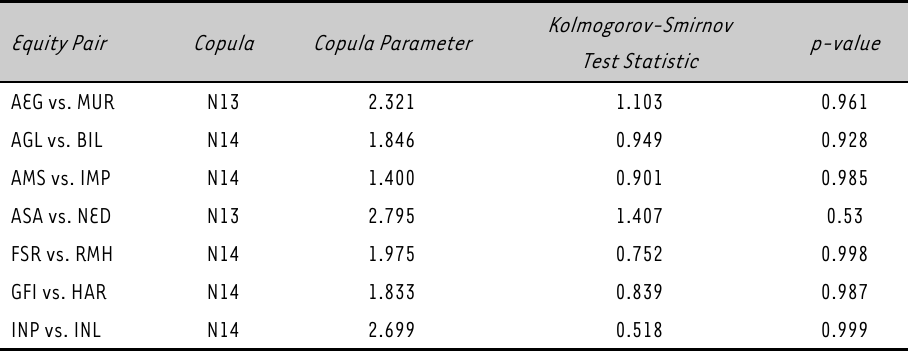
TABLE 2: Goodness-of-fit test statistics and p-values for various stock pairs Equity Pair Copula Copula Parameter